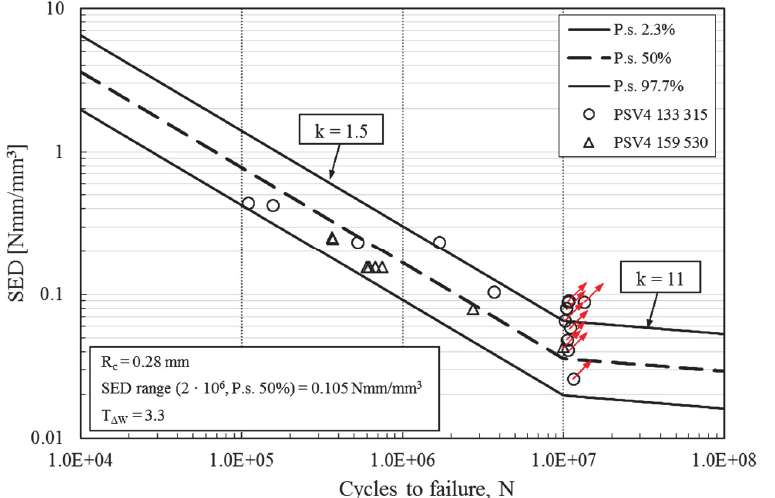
Figure 3: Synthesis of new data in terms of local SED and comparison with the scatterband by Lazzarin and co-authors.